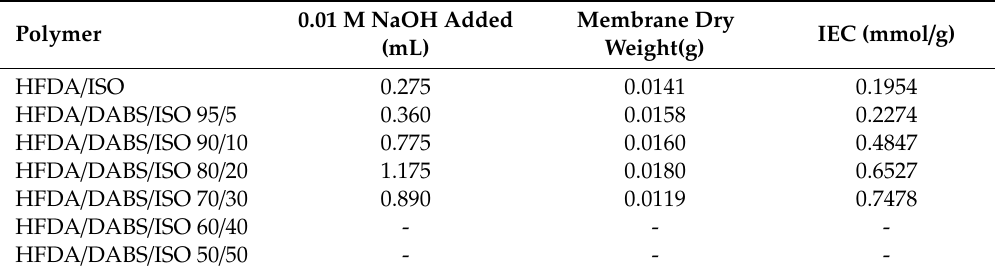
Table 4. IEC results of copolyamides based on HFDA / ISO and HFDA / DABS / ISO copolymers performed at room